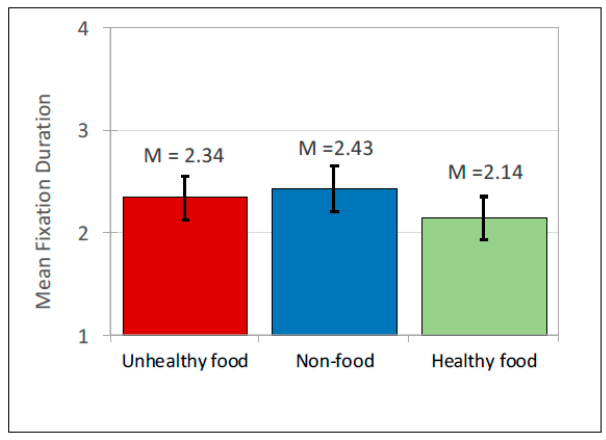
Figure 11. Fixation duration: Mean scores. Table 7. Fixation count and duration: Means, standard deviations, and 95% confidence